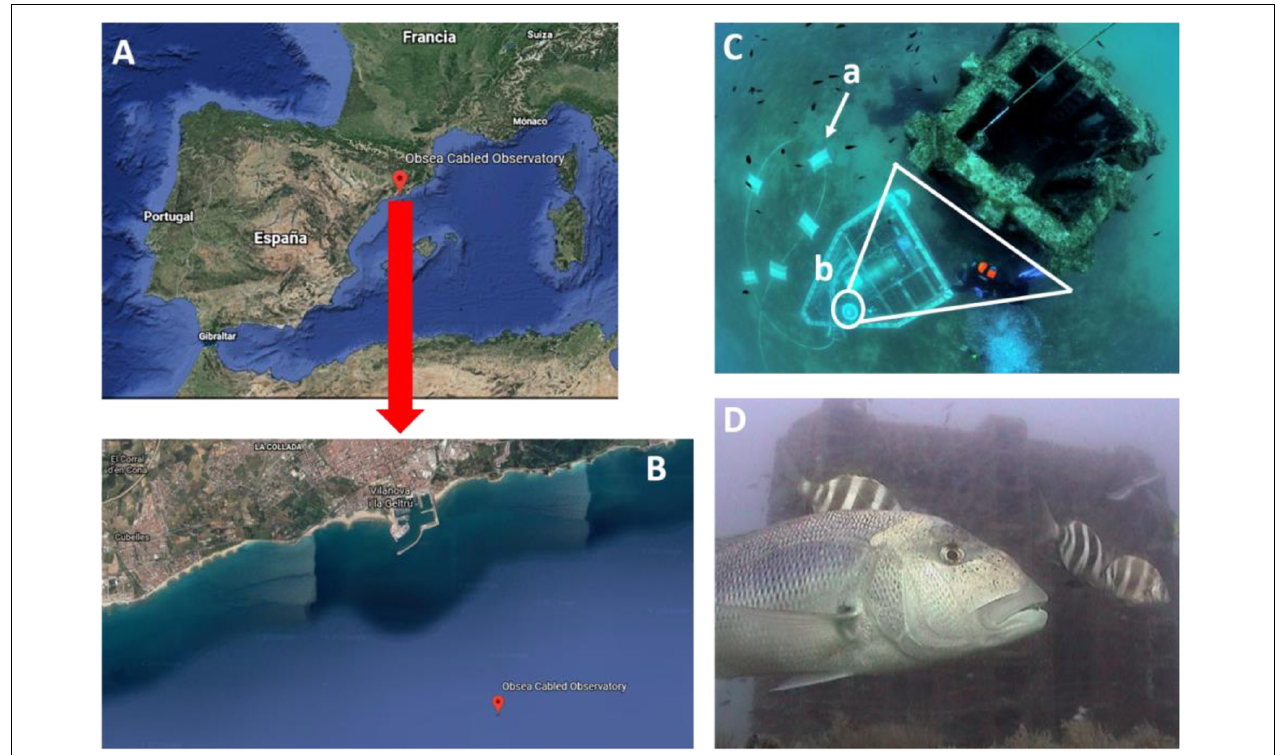
FIGURE 1 | Location of the OBSEA video platform in the NW Mediterranean (A) with specifications for the Catalan coasts, indicating its position off the harbor of Vilanova i la Geltrú (B) . The OBSEA platform is connected to shore with an Ethernet powering/data transfer cable (C.a) , camera focusing on the artificial reef (C.b) , where the number of individuals per photo of D. dentex can be observed and counted within a constant field of view (D)